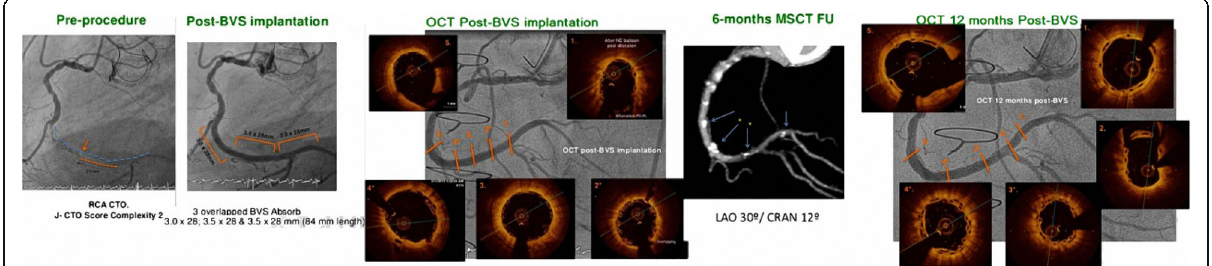
Fig. 3 First panel from the Lt. side: Coronary angiography of CTO of mid RCA with J-CTO score complexity = 2. Second panel: Post-BVS implantation of 3 overlapped BVS Absorb (3.0 × 28; 3.5 × 28, and 3.5 × 28 mm (84 mm length). Third panel: OCT Post-BVS implantation. Fourth panel: 6 months MSCT follow-up. Fifth panel: OCT 12 months